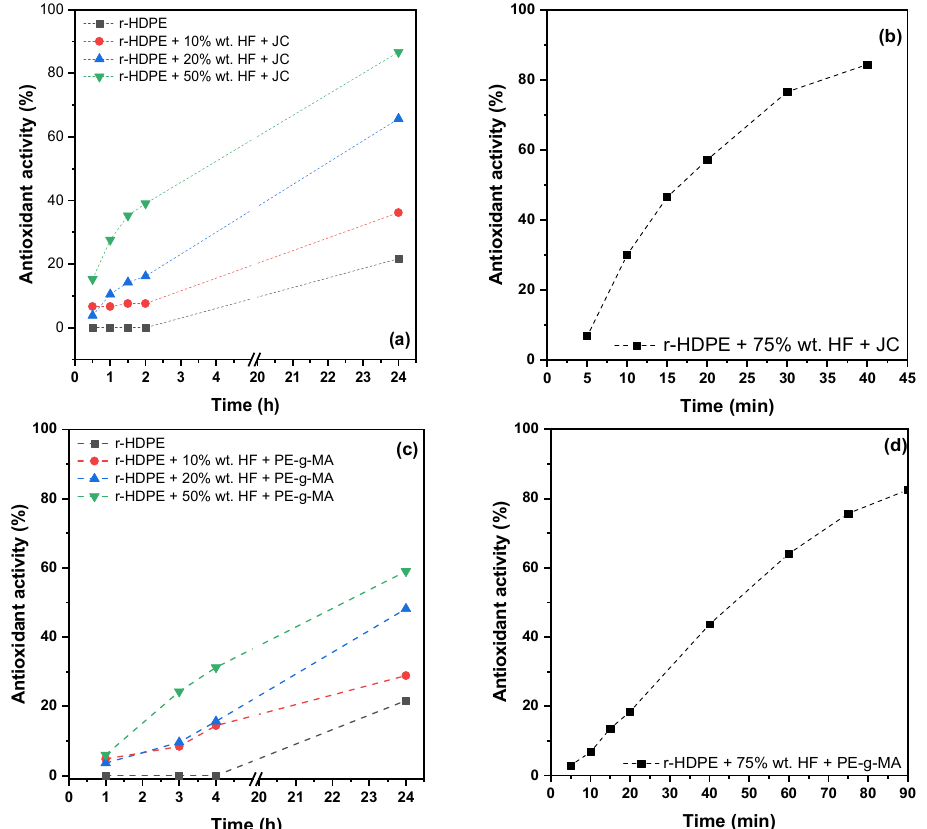
Figure 15. Antioxidant activity of ( a ) recycled high-density polyethylene (r-HDPE) + 10–50% wt. hemp fibers (HF) + Joncryl (JC), ( b ) r-HDPE + 75% wt. HF + JC ( c ) r-HDPE + 10–50% wt. HF + polyethylene-grafted maleic anhydride (PE-g-MA), and ( d ) r-HDPE + 75% wt. HF + PE-g-MA composite films in DPPH/ethanol solution.